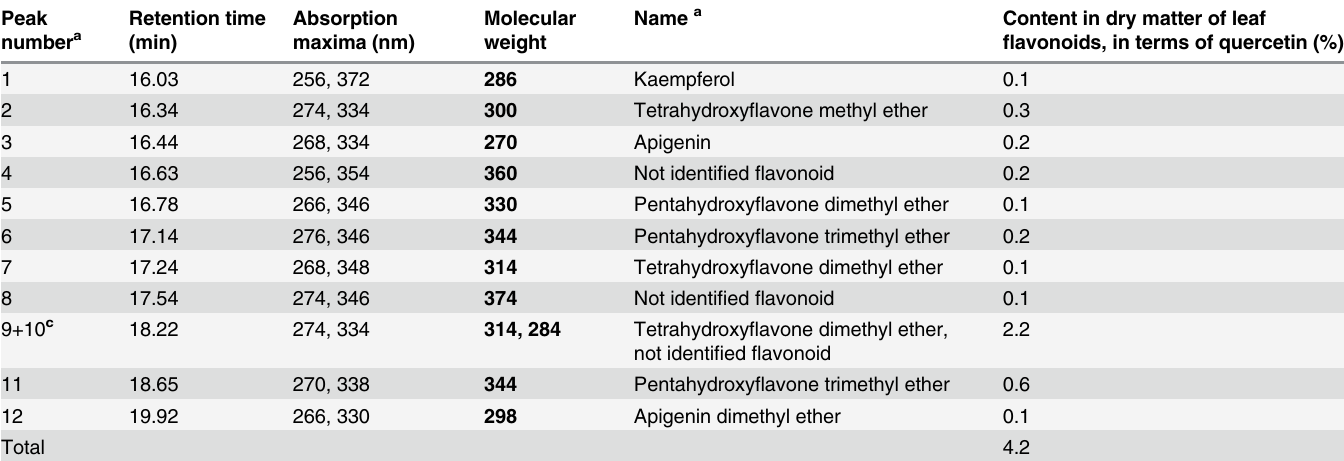
Table 1. Content of individual flavonoid aglycones washed from Betula pendula leaves surface. Retention time Peak number a